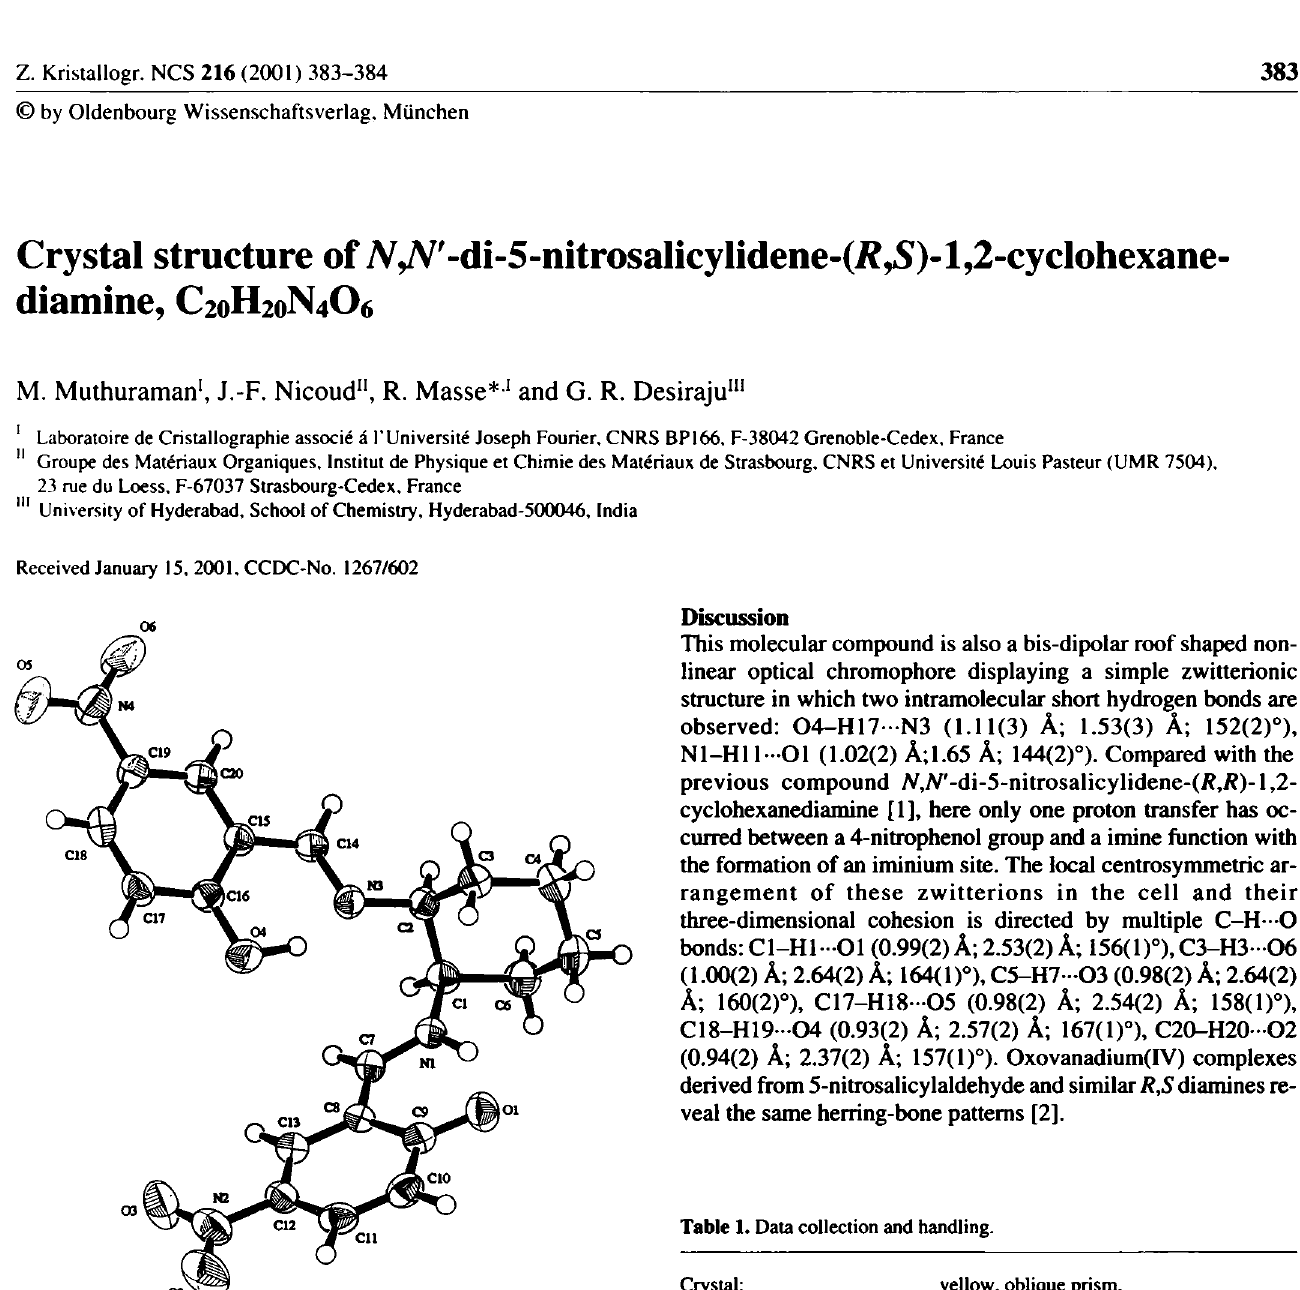
Table 1. Data collection and handling.